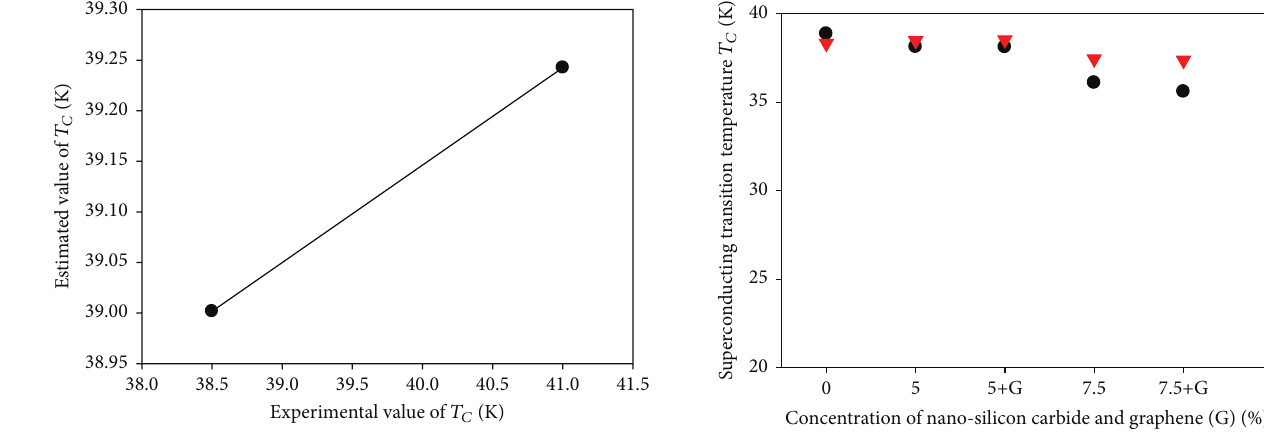
Figure1:Correlationbetweentheexperimentalandestimatedvalue of 𝑇 𝐶 during the testing phase of STTE.